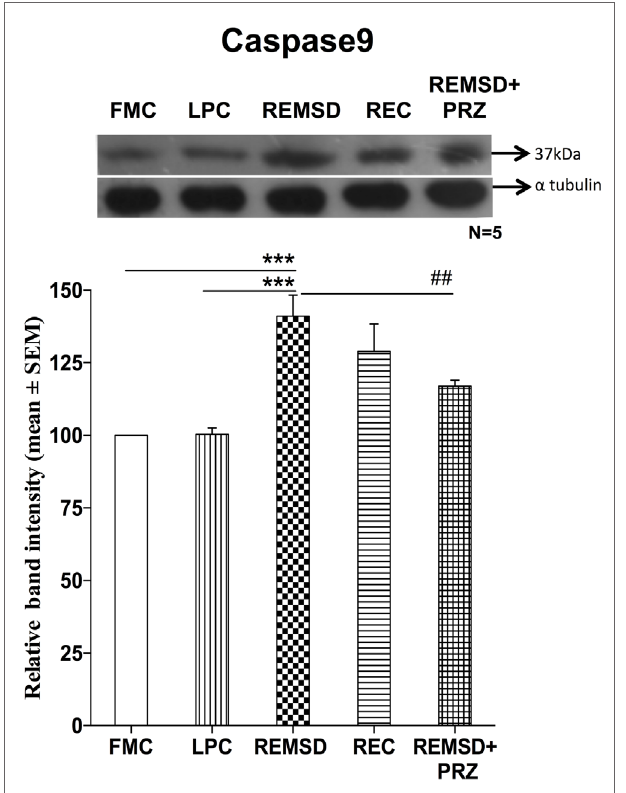
FigUre 6 | caspase3 expressions in the brain homogenate of rats under different conditions . Upper panel shows a representative Western blot showing the presence of procaspase3 and cleaved caspase3. Histogram in the lower panel shows percent changes in the mean ( ± SEM) band densities, which were sum of both the Procaspase3 and cleaved caspase3 as compared to FMC taken as 100% in five sets of experiments. Abbreviations are as in the text. Significance levels are between the treatments of connecting horizontal bars; *** p < 0.001, * as compared to FMC and # as compared to REMSD.